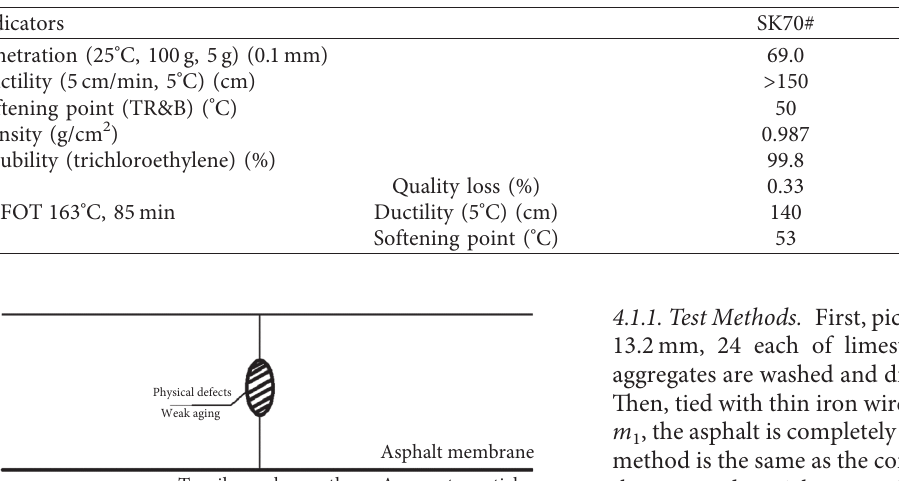
Table 2: The performance indicators of